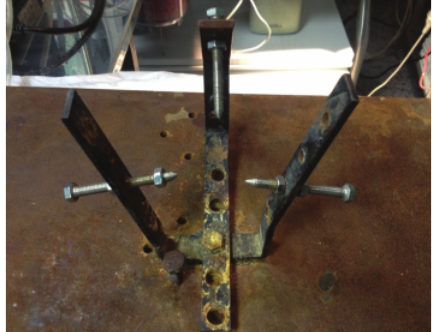
Figure 1: The offhand three-dimensional frame used to stabilize the head of the rabbit.